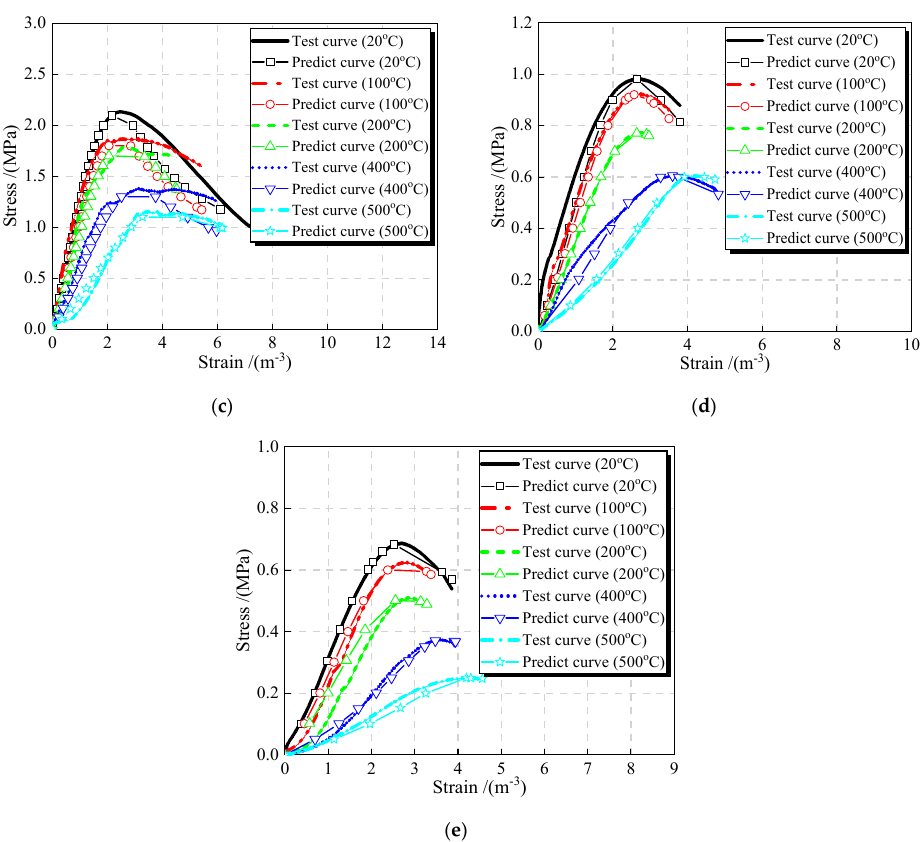
Figure 16. Model validation. ( a ) r = 0%. ( b ) r = 25%. ( c ) r = 50%. ( d ) r = 75%. ( e ) r = 100%